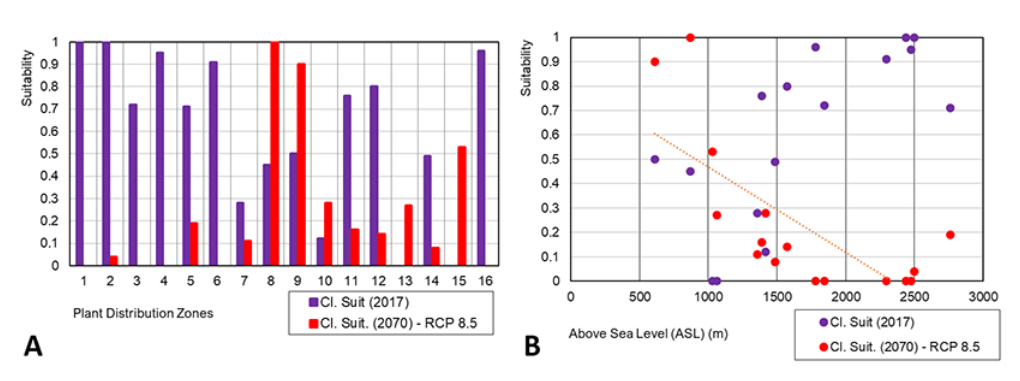
Figure 6 e climatic suitability for current and future conditions ( A ), and the climatic suitability change based on altitude ( B